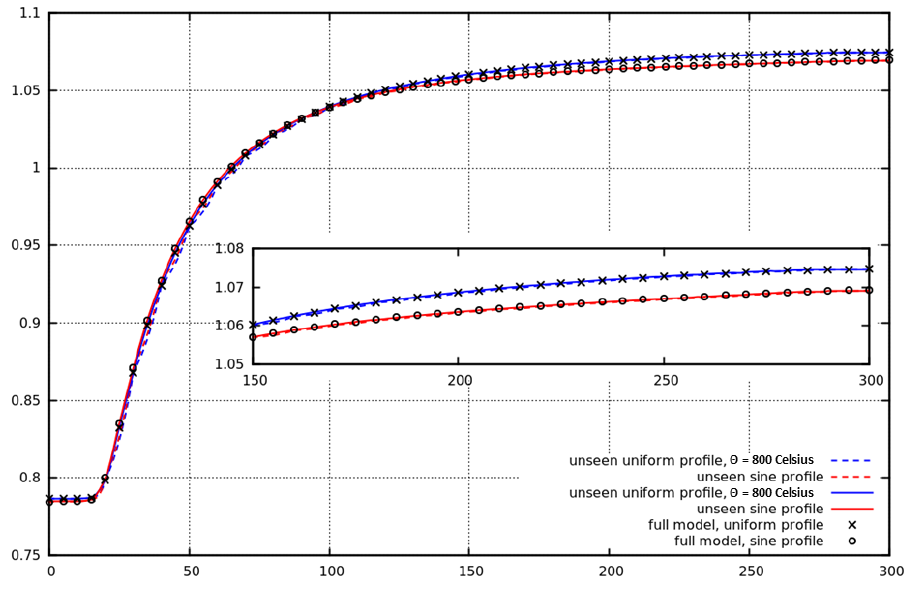
Figure 12. k eff against control-rod height. The dotted line corresponds to the reduced-order model results (LPOD) using the linear interpolation, and the solid line corresponds to the nonlinear interpo- lation. Two unseen temperature profiles are used—the first is uniform and the second sinusoidal (see Equation (48)). For comparison, high-fidelity model results are